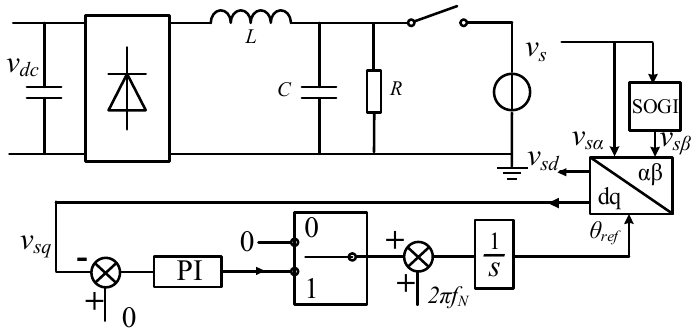
Figure 10. Control strategy for SPEER grid-connected pre-synchronization.